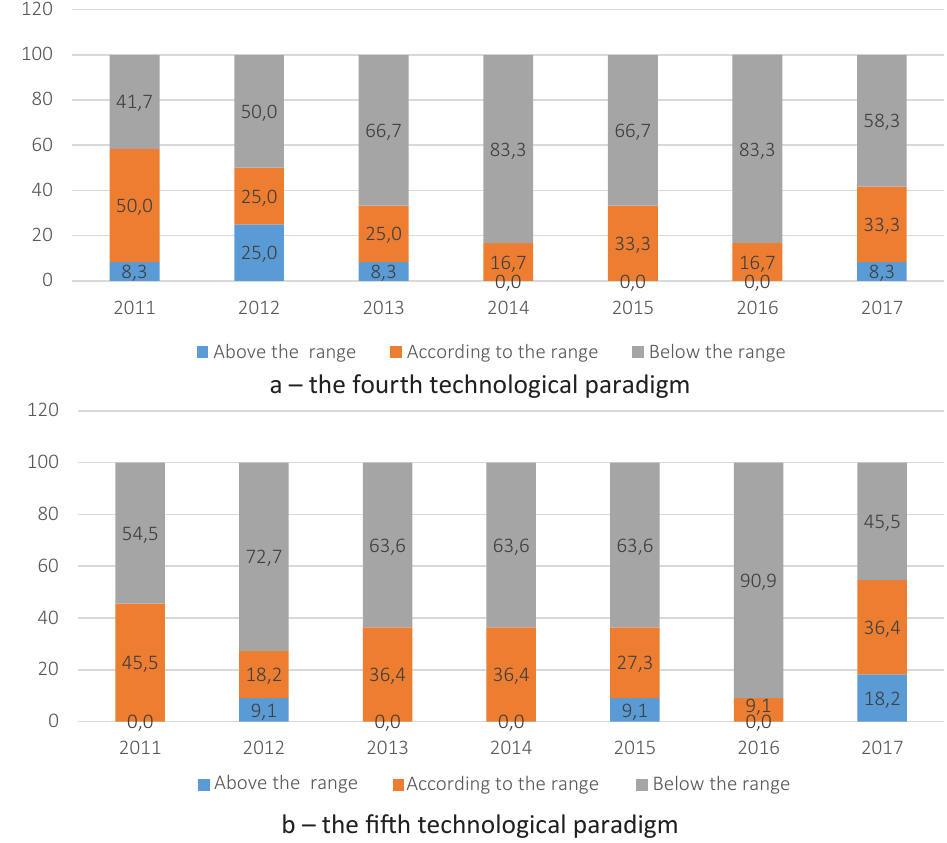
Figure 4. Distribution of machine-building enterprises by the level of management system